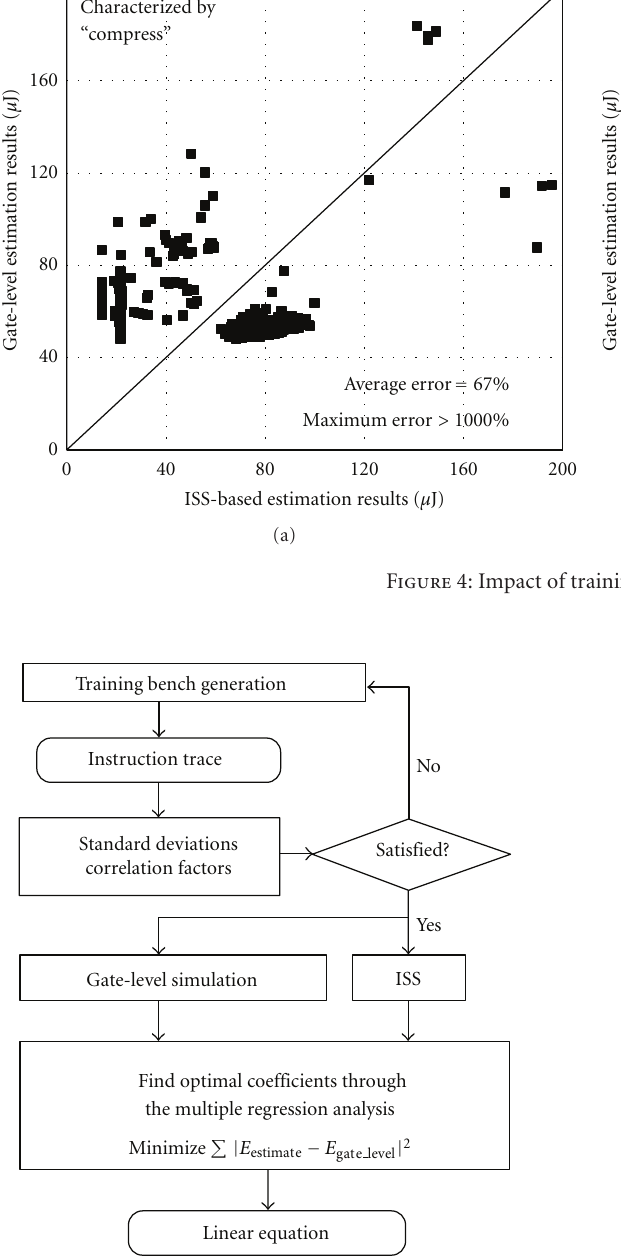
Figure 5: Training bench generation.